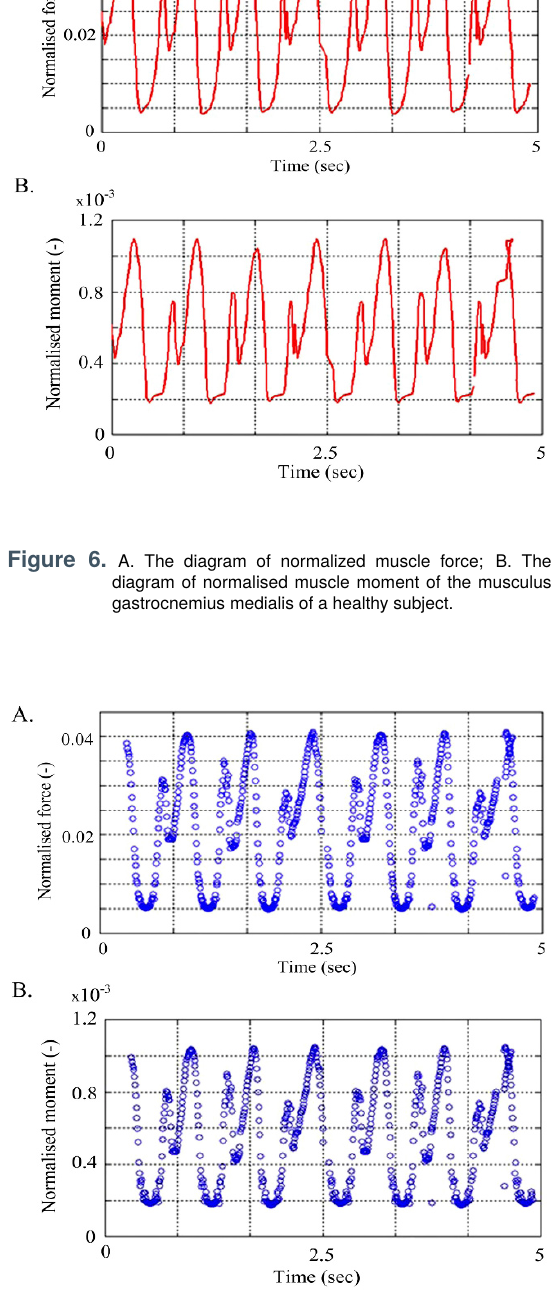
Figure 7. A. The diagram of predicted muscle force; B. The diagram of predicted muscle moment of the musculus gastrocnemius medialis of a healthy subject.